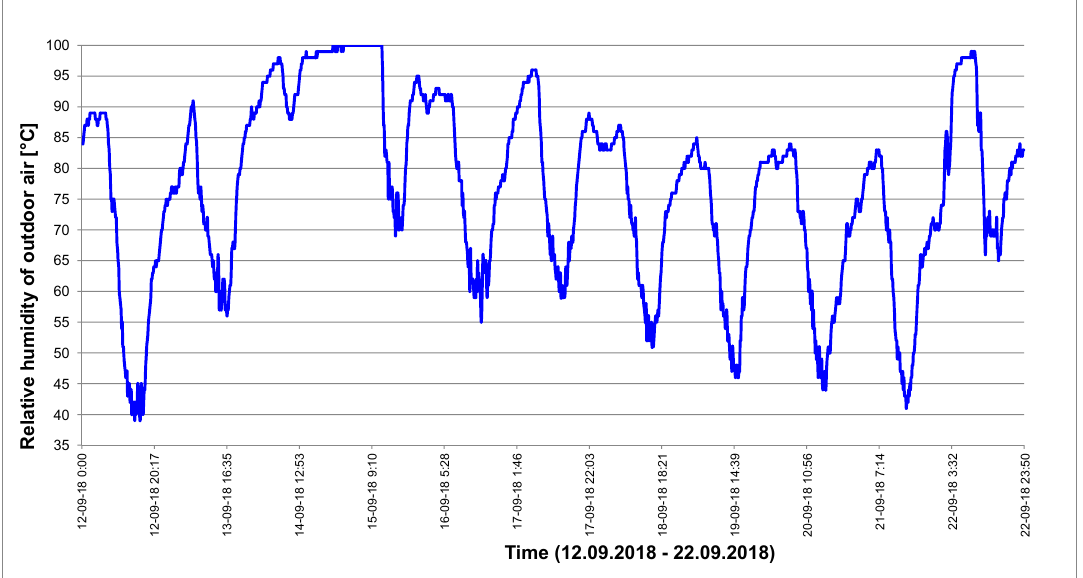
Time (12.09.2018 - 22.09.2018) Figure 4. Relative humidity distribution of the outdoor air obtained on the basis of measurements carried out in the period from 12 September 2018 to 22 September 2018.